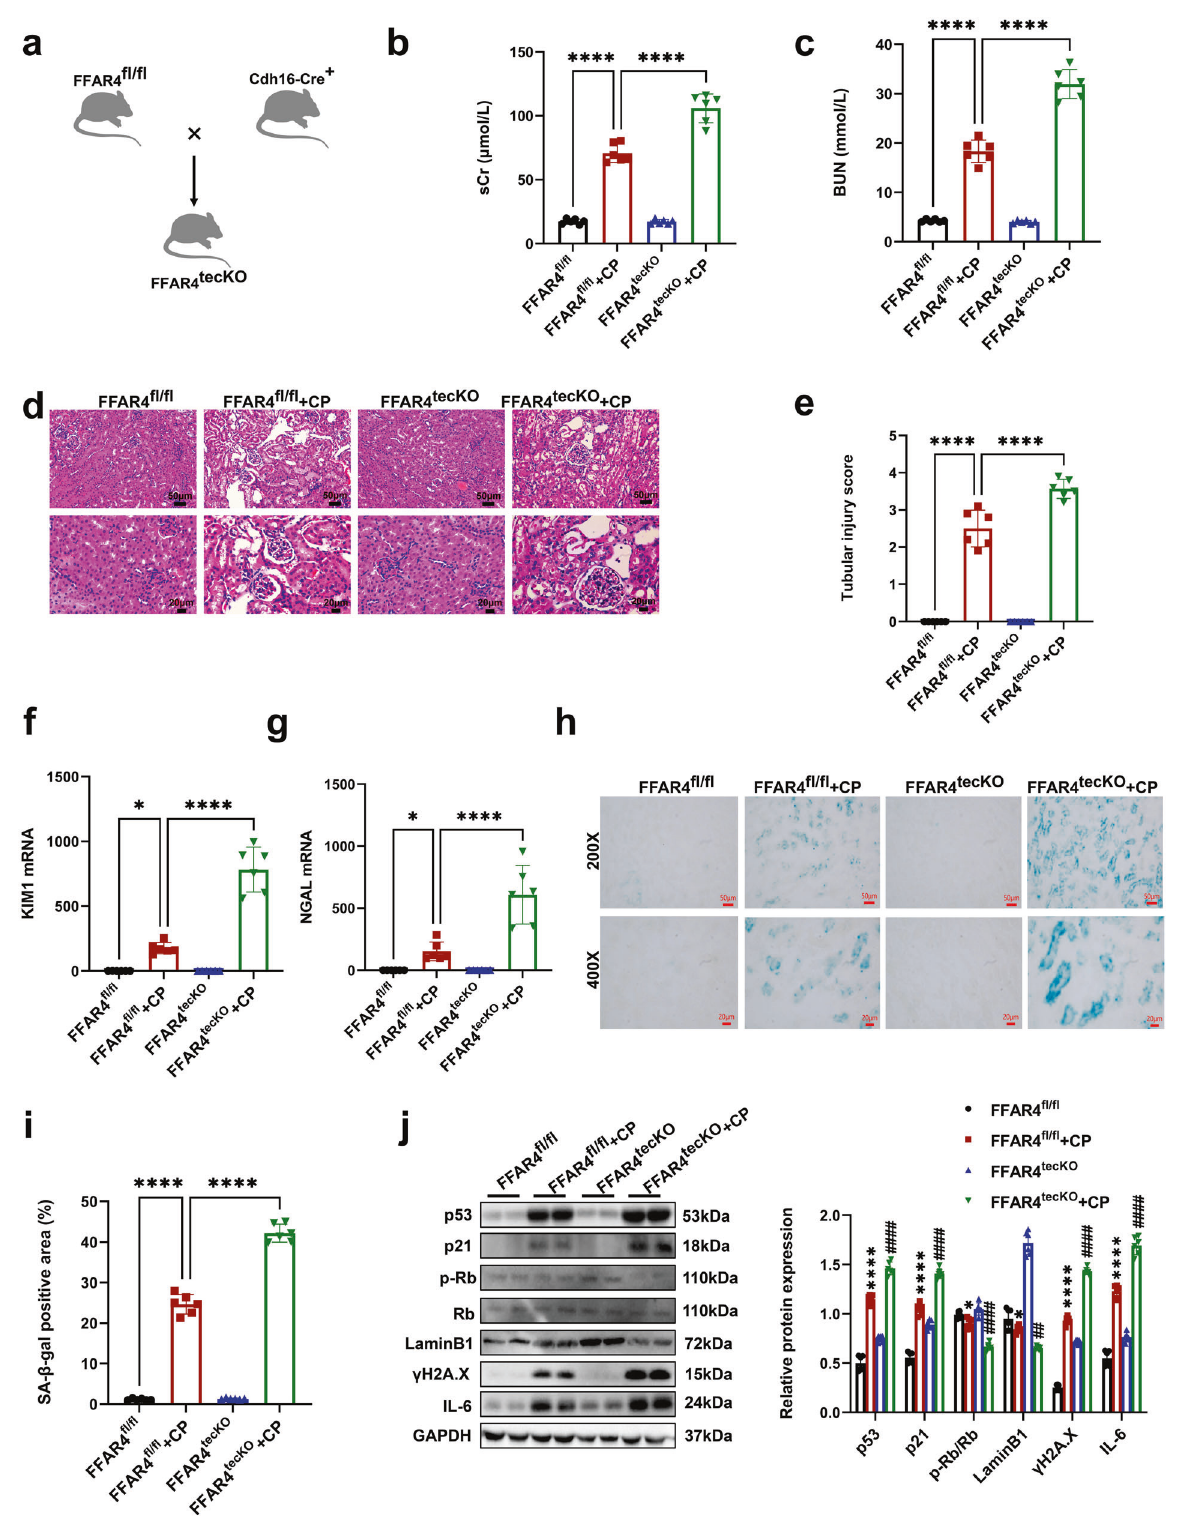
Fig. 11 Tubular epithelial cell-speci fi c deletion of FFAR4 aggravated kidney damage and cellular senescence in cisplatin-induced AKI mice. a Mating strategy to generate FFAR4 conditional KO in mouse TECs. b , c The sCr and BUN levels in different groups of mice ( n = 6; **** P < 0.0001). d Representative images of H&E staining (200×, scale bar = 50 μ m; 400×, scale bar = 20 μ m). e Tubular injury scores of kidney tissues ( n = 6; **** P < 0.0001, *** P < 0.001). f , g Relative mRNA expression of KIM1 and NGAL in kidney tissues ( n = 6; **** P < 0.0001, * P <